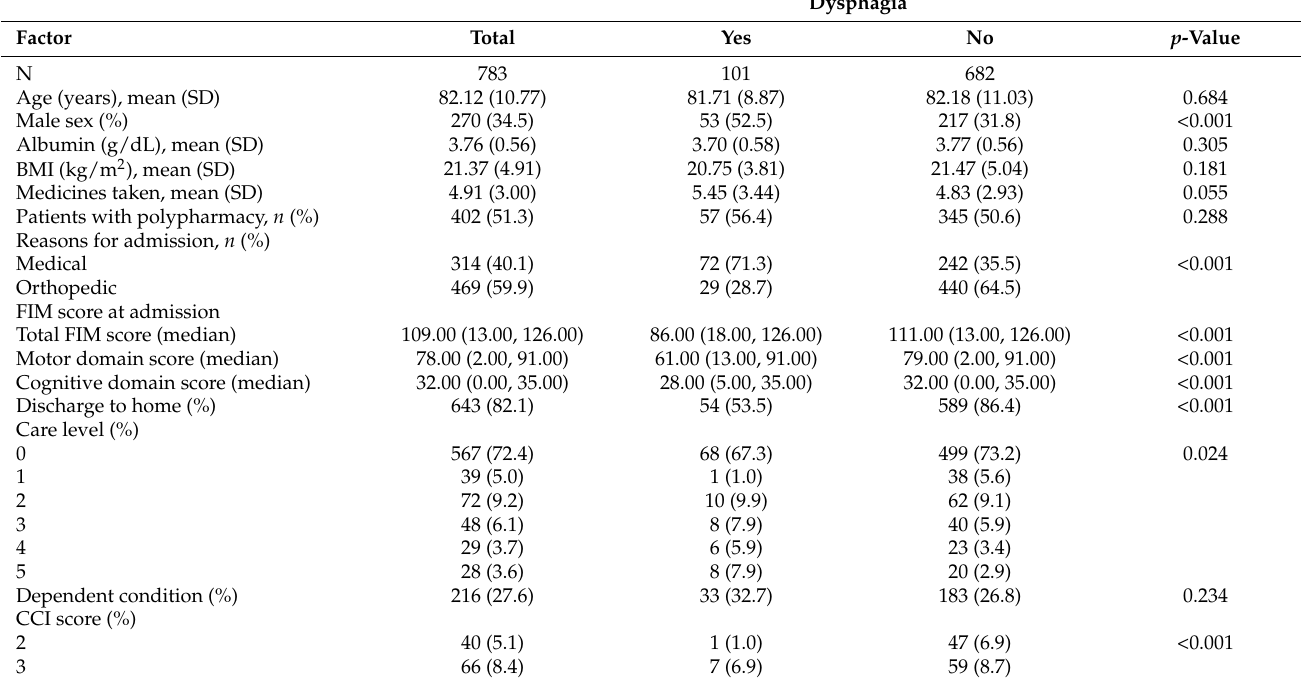
Table 3. Demographics of the participants.